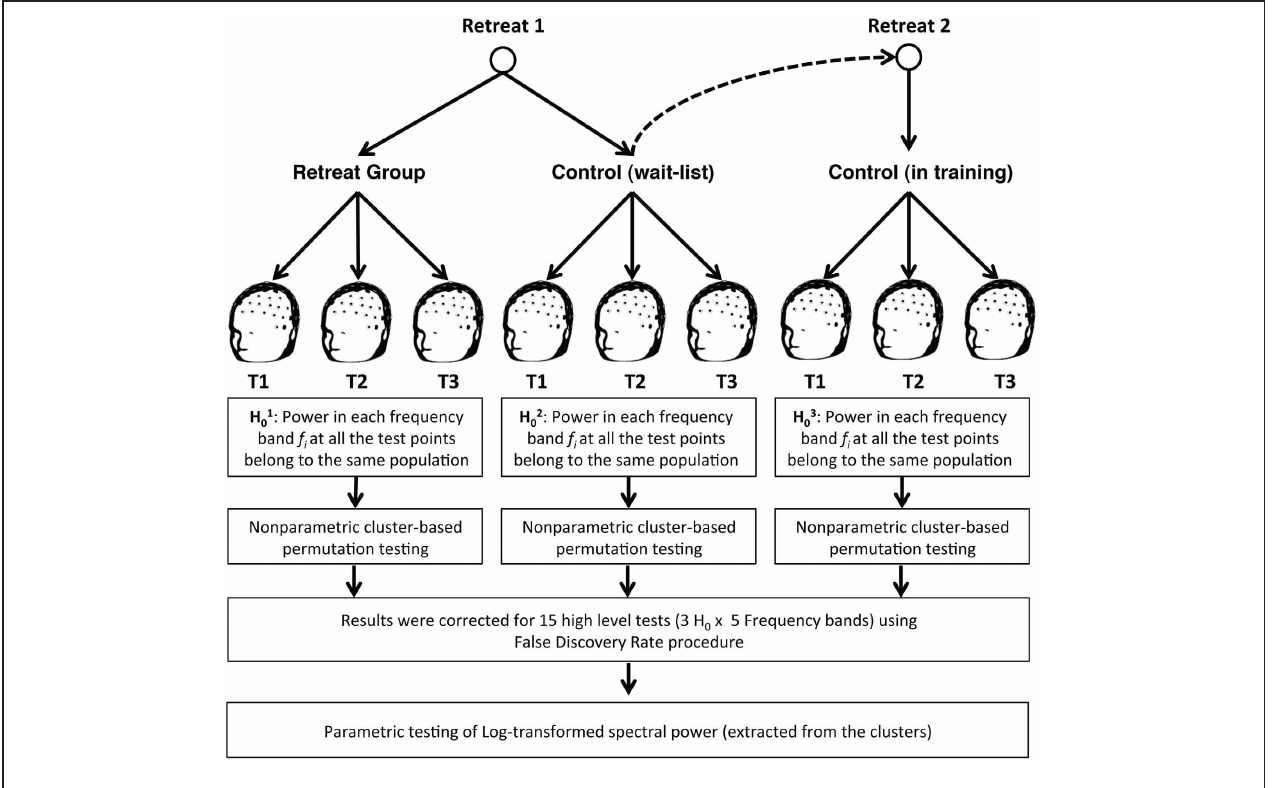
FIGURE 2 | Groups were tested three times during each three-month retreat period: at the beginning (pre-assessment), middle (mid-assessment), and end (post-assessment) of each retreat. After estimating spectral power in each band, non-parametric cluster-based